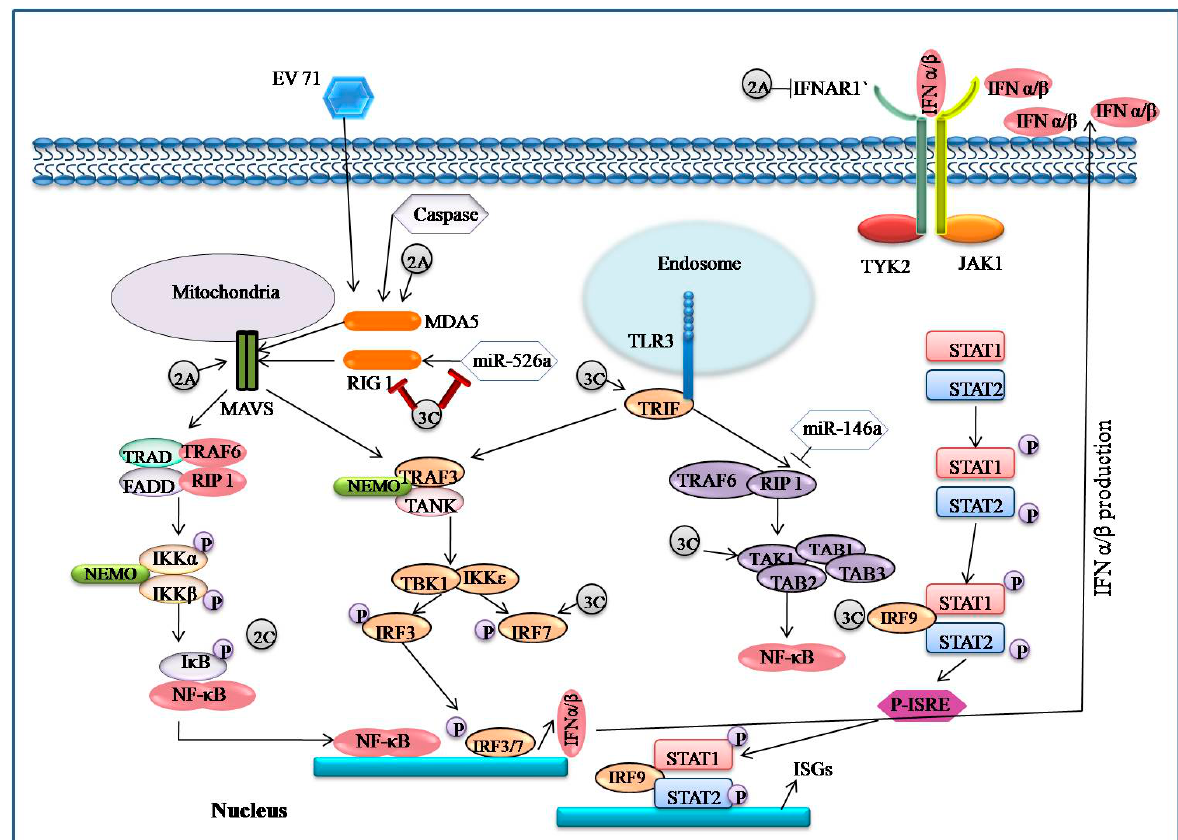
Figure 4. Evasion of PRRsmediated signaling pathways by EV71. By means of the non-structural proteins 2A, 2C, and 3C, EV targets the PRRs signaling pathway. 2A degrades IFNAR1 and cleaves MAVS and MDA5. RIG-1 and MAVS complex is cleavedby 3C which also inactivates TRIF. The activation of RIG-1 bymir-526a is inhibited by 3C and by promoting the expression of miR-146a.